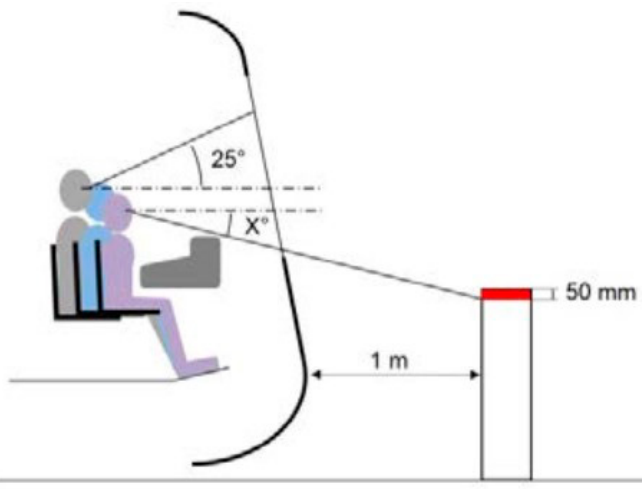
Figure 5. Driver view and blind spot detection using Metaverse.